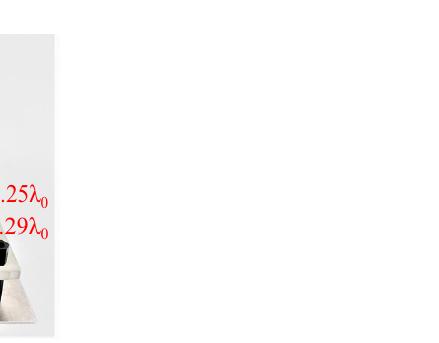
Figure 11. Photograph of the assembled prototype with the DF-PTS and the